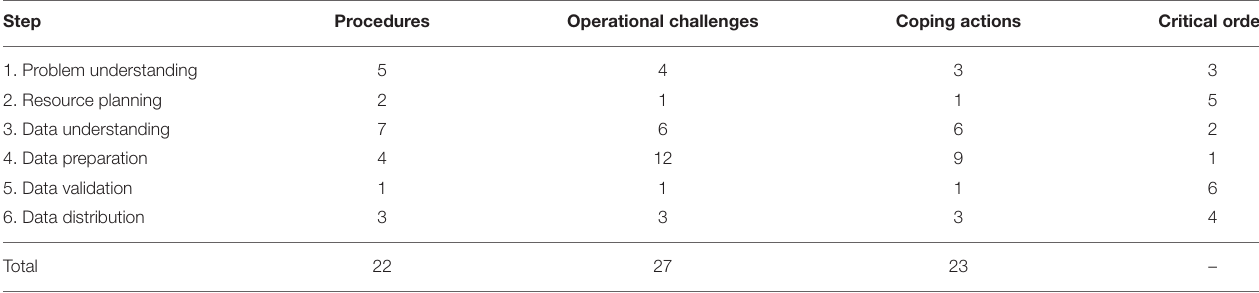
* The procedures are listed in Table 1 , ** operational challenges and coping actions in Table 2